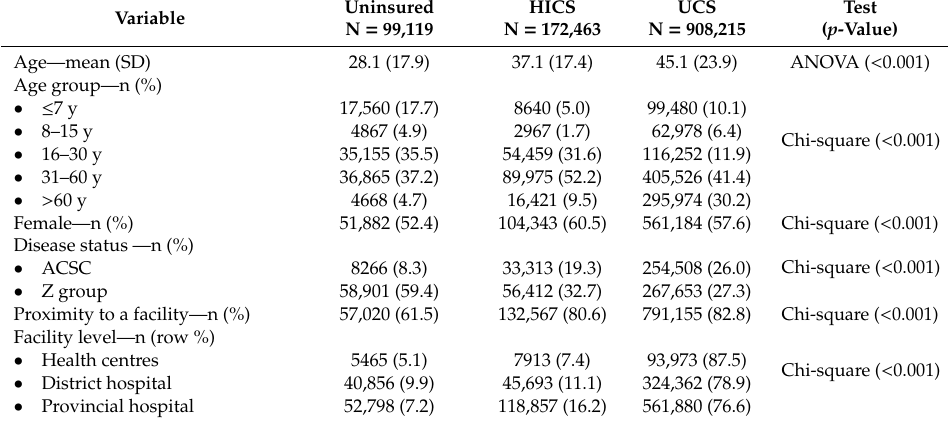
Figure 5. Percentage of outpatient (OP) utilisation in Ranong Hospital ( A ), Kraburi Hospital ( B ), and Health Centres A and B ( C ) by age. Table 3. Comparison of the sum of OP visits by personal attributes and insurance